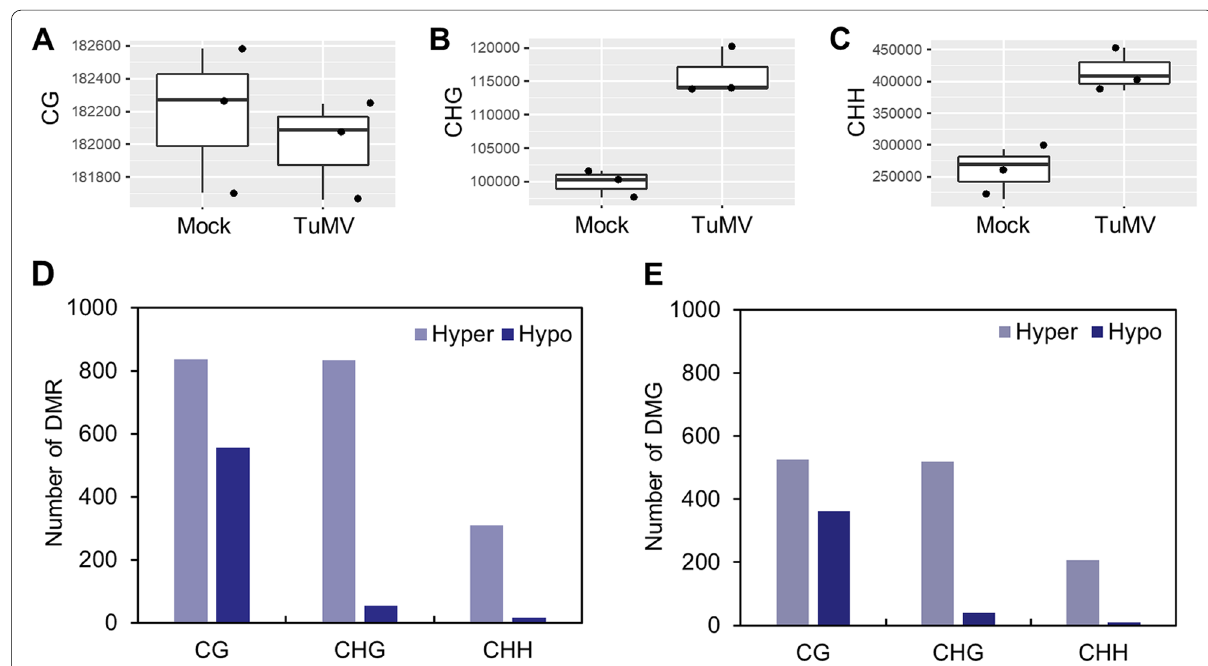
Fig. 1 Whole-genome bisulfite sequencing (WGBS) of mock and TuMV-infected leaf tissues. A - C number of methylated sites of CG ( A ), CHG ( B ), and CHH ( C ), respectively. D Number of hyper- or hypomethylated differentially methylated regions (DMRs) in CpG, CHG, and CHH contexts. E Number of hyper- or hypomethylated DMRs-associated genes (DMGs) in CpG, CHG, and CHH